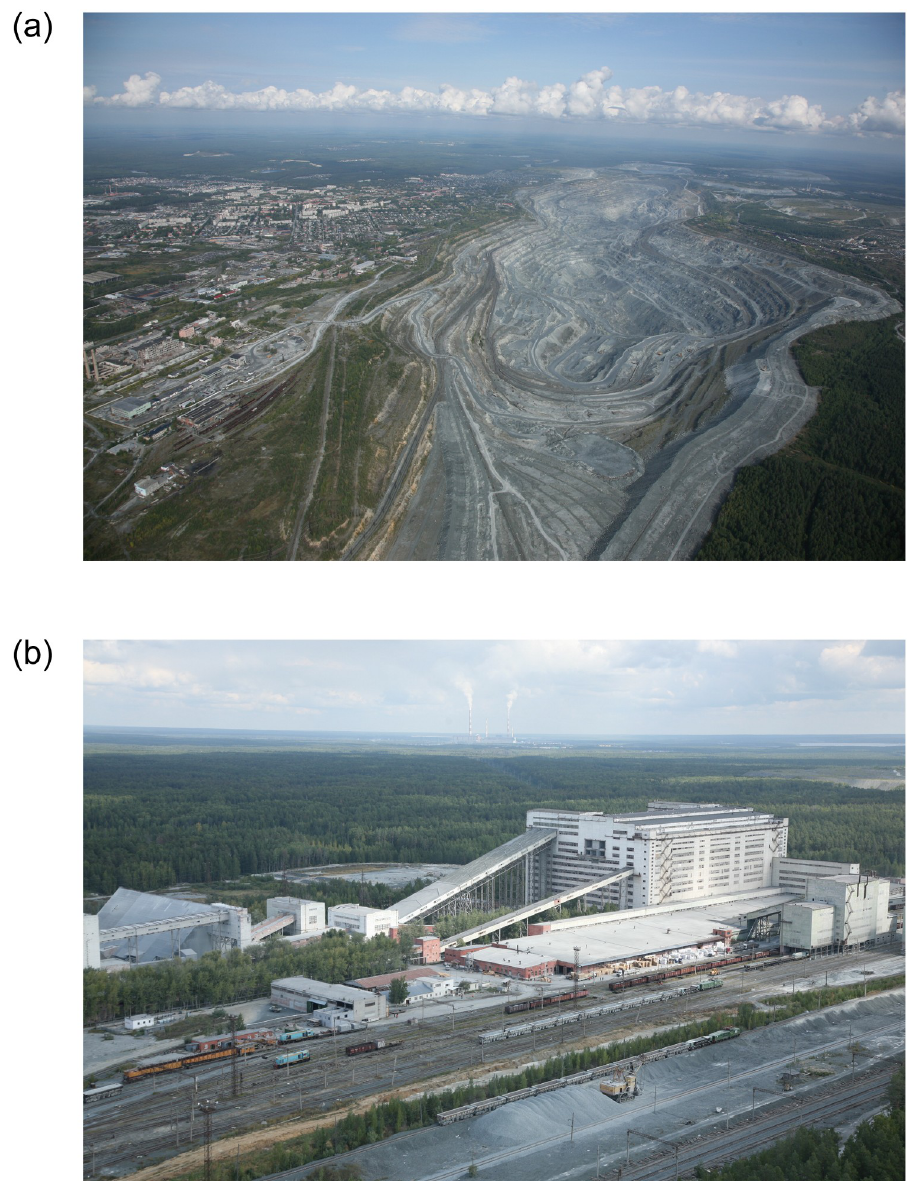
Fig 1. A . Open-pit mine in Asbest, Sverdlovsk oblast, the Russian Federation (photo provided by JSC Uralasbest). B . Enrichment factory #6 of JSC Uralasbest, Asbest, Sverdlovsk oblast, the Russian Federation (photo provided by JSC